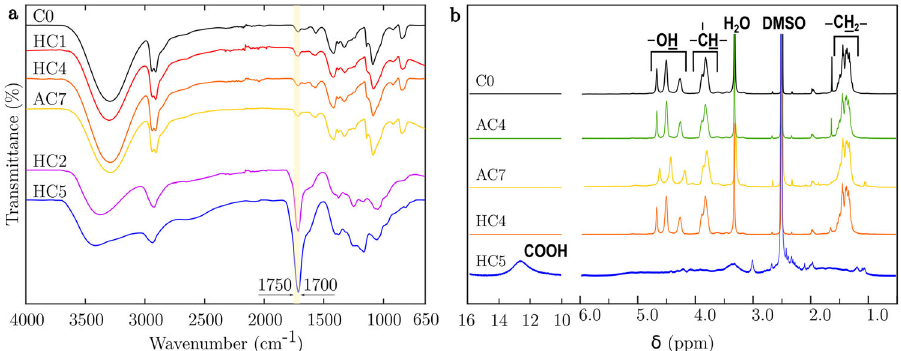
Fig. 2 FTIR and 1 H NMR spectroscopy. ( a ) FTIR spectra of virgin PVOH (C0) and PVOH samples treated with HC (HC1, HC2, HC4, HC5) and AC (AC7). The carbonyl band (marked yellow) con fi rms the presence of the aldehyde, ketone, or carboxyl functional groups in the PVOH structure, resulting from oxidation and main chain scission; ( b ) 1 H NMR spectra of virgin PVOH (C0) and PVOH samples treated with HC (HC4 and HC5) and AC (AC4 and